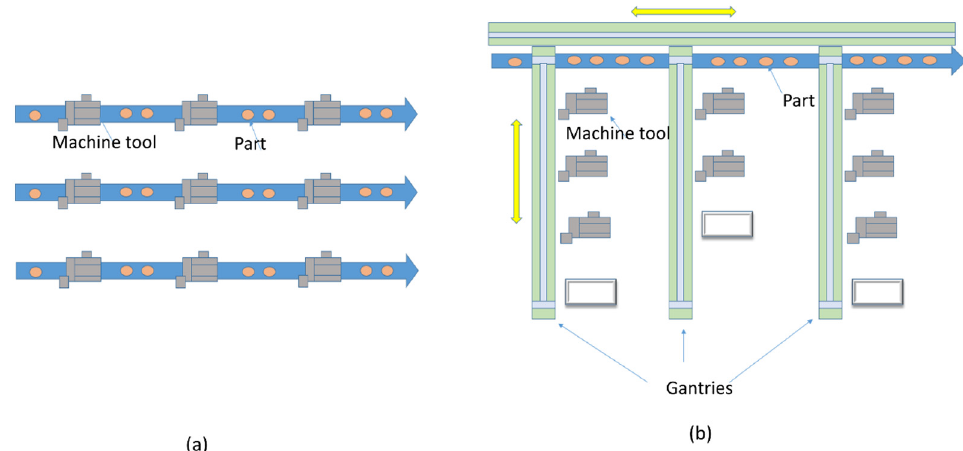
Figure 12. Schematic layout of ( a ) SLP configuration and ( b ) RMS configuration. Reprinted with permission from ref. [3]. Copyright 2018 Springer.